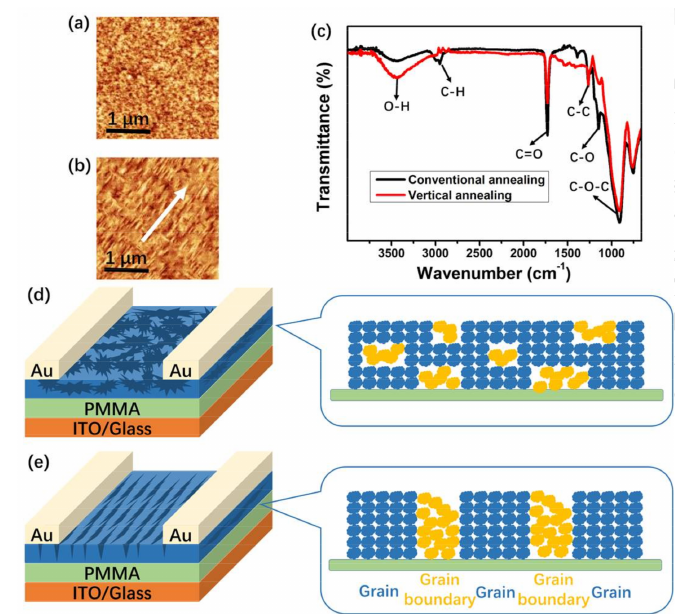
Figure 4. AFM topography images of TIPS-pentacene films of conventional device ( a ) and the perpendicular device ( b ). FTIR spectra of TIPS-pentacene films with the PMMA dielectric formed by conventional and vertical annealing methods ( c ). Schematic diagrams of crystallization orientation of parallel device ( d ) and the perpendicular device ( e ).